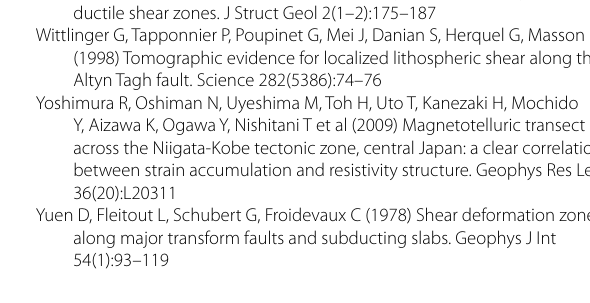
gradient data. Earth Planets Space 56(12):1191–1194 Thatcher W, England PC (1998) Ductile shear zones beneath strike-slip faults: implications for the thermomechanics of the San Andreas Fault Zone. J Geophys Res Solid Earth 103(B1):891–905 Tullis J, Yund RA (1982) Grain growth kinetics of quartz and calcite aggregates. J Geol 90:301–318 White S (1979) Grain and sub-grain size variations across a mylonite zone. Contrib Mineral Petrol